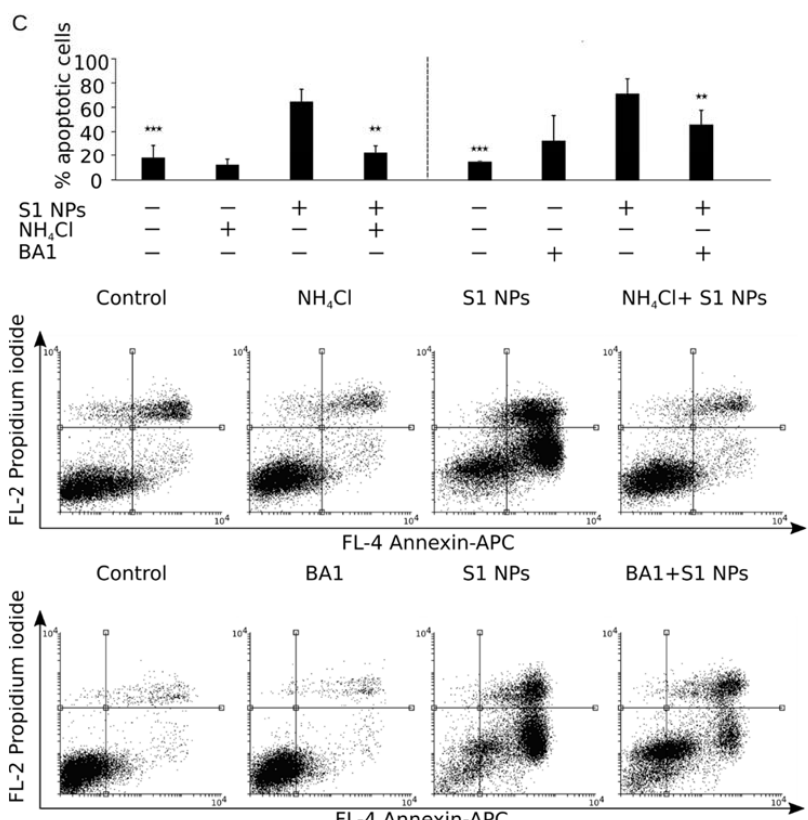
Figure 9. The effect of acidification inhibition of the cells on apoptosis induced by NaGdF 4 -based nanoparticles (2.5 µ g/mL). ( A ) 50 nM Bafilomycin A1 (BA1) or 5 mM NH 4 Cl prevents acidification detected by Lysotracker green; ( B ) dot-plot analysis of the mitochondrial potential (MMP) measured using the JC-1 mitochondrial probe. Representative dot plots are shown; ( C ) Dot plot analysis of Annexin V and propidium iodide staining indicating the apoptotic process. Representative dot-plots are shown. Bar graphs show the analysis of 3 independent experiments. The average of apoptotic cells are shown (AnnexinV+/PI − and AnnexinV+/PI+) ± SD. * p < 0.05; ** p < 0.01; *** p < 0.001. All comparisons were performed with respect to S1 NPs treated cells.